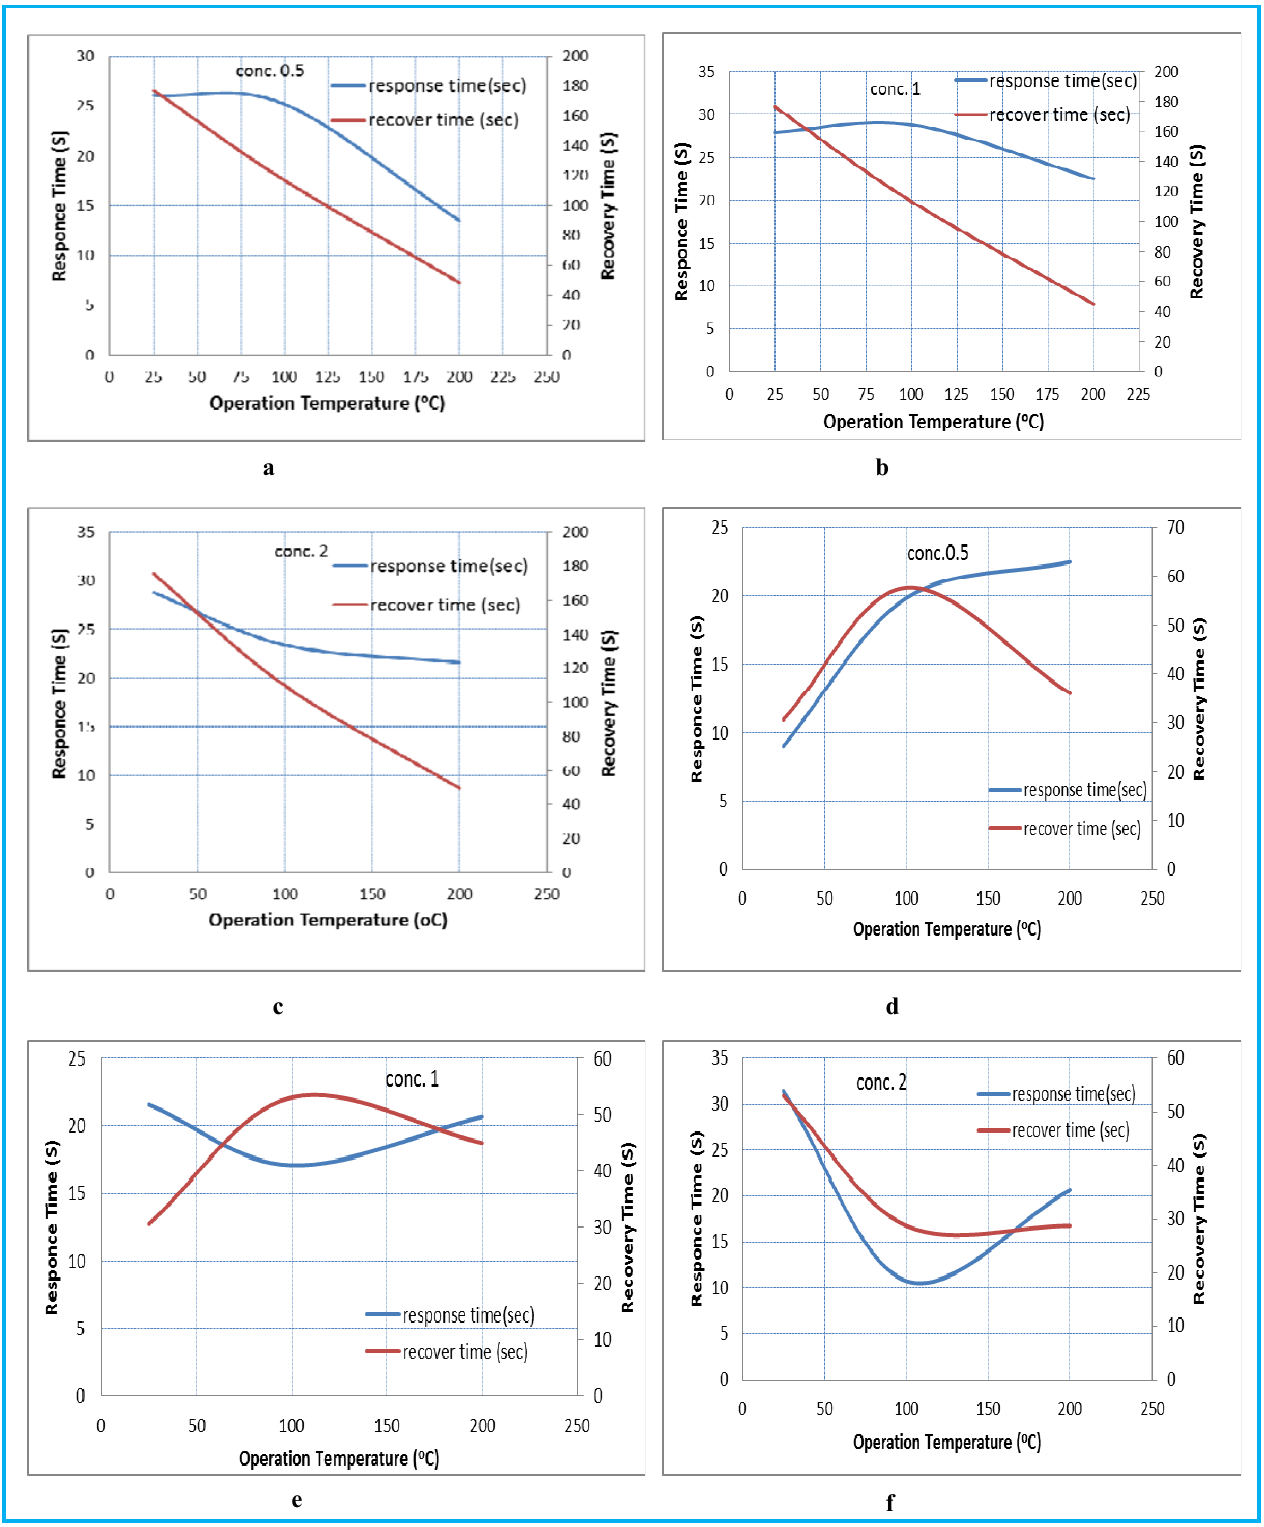
Fig. 12: The variation response time and recovery time with operating temperature for Si/NiPcTs/ PEDOT:PSS bulk heterojunctions blend thin films of different PEDOT:PSS concentrations.(a, b, c) forNO gas and (d, e, f) for NH 2 3